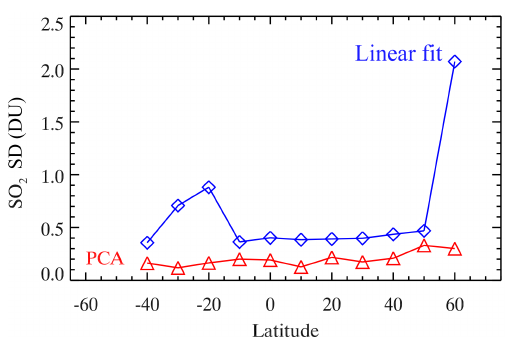
Figure 4. Standard deviation of TRL total SO 2 vertical column density retrieved for 10 ◦ latitude bands over the remote Pacific (170–180 ◦ W) on 5 August 2006 with the linear fit (blue line) and OMSO2VOLCANO (PCA, red line)